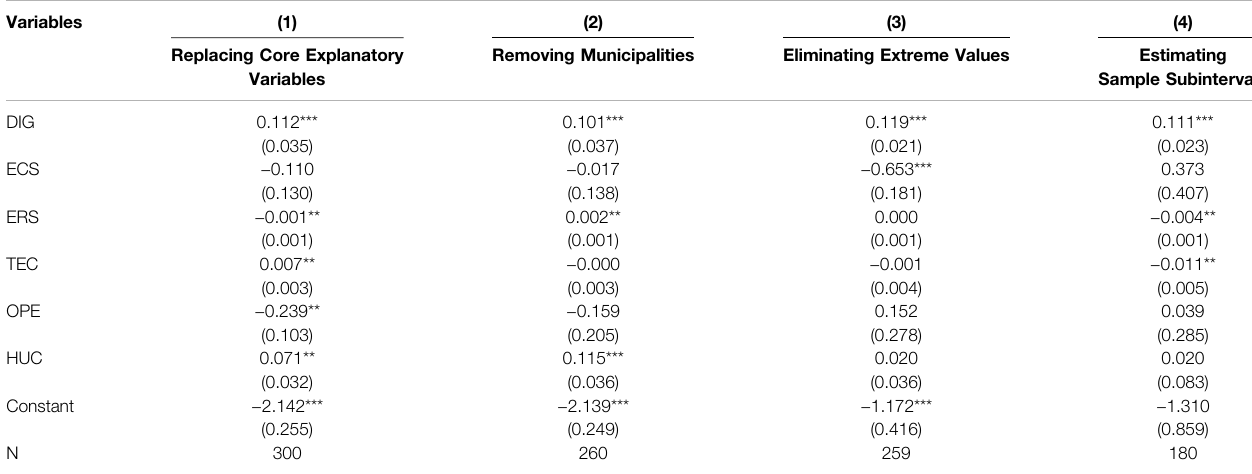
TABLE 6 | Robustness test results.